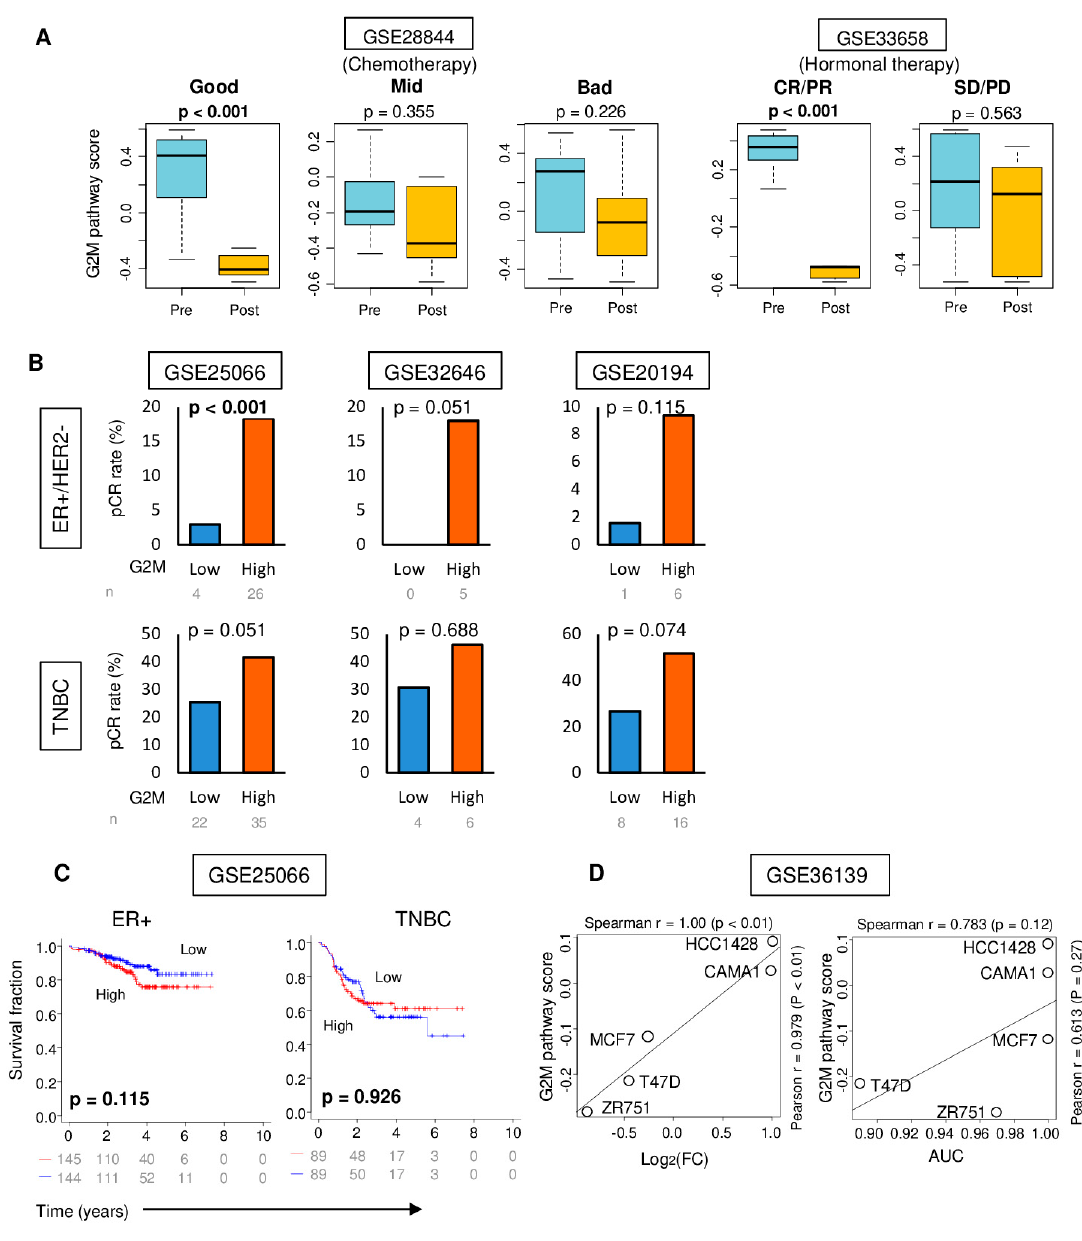
Figure 6. ( A ) Boxplots depicting the scores of pre- and post- treatment using the GSE28844 and GSE33658 cohorts. GSE28844 used neoadjuvant chemotherapy and GSE33658 used endocrine therapy. In GSE28844, response was categorized as Miller–Payne criteria. RECIST criteria were used for GSE33658. ( B ) Bar plots depicting the pCR rates between high- and low G2M pathway score groups among patients with ER-positive / HER2-negative tumors and TNBCs in the GSE25066 ( n = 508), GSE32646 ( n = 115), and GSE20194 ( n = 278) cohorts. ( C ) Kaplan–Meier plots with logrank test p -values; DFS between the high- and low-G2M pathway score groups. ER-positive / HER2-negative and TNBC patients in the GSE25066 cohort. ( D ) Correlation plot between the G2M pathway score and fold-change ( FC ) and area under the curve ( AUC ) using the GSE36139 cohort. AUC, area under the curve; CR, complete response; DFS, disease-free survival; ER, estrogen-receptor; FC, fold-change; pCR, pathological complete response; PD, progressive disease; PR, partial response; RECIST, The Response Evaluation Criteria in Solid Tumors; SD, stable disease; TNBC, triple-negative breast cancer.